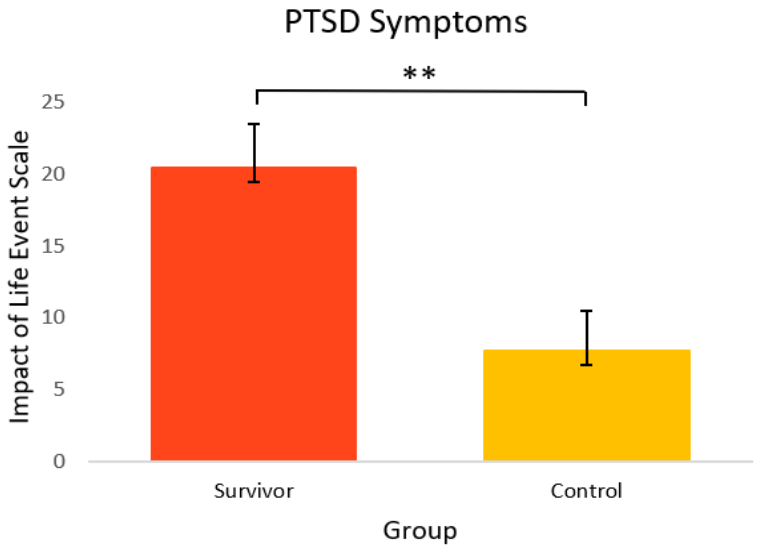
Figure 5. PTSD symptoms in cancer survivors and healthy controls. Group means are presented. Error bars represent standard error of the mean (SEM). Significance is denoted by ** at the p < 0.01 level. Group n = 14–10.